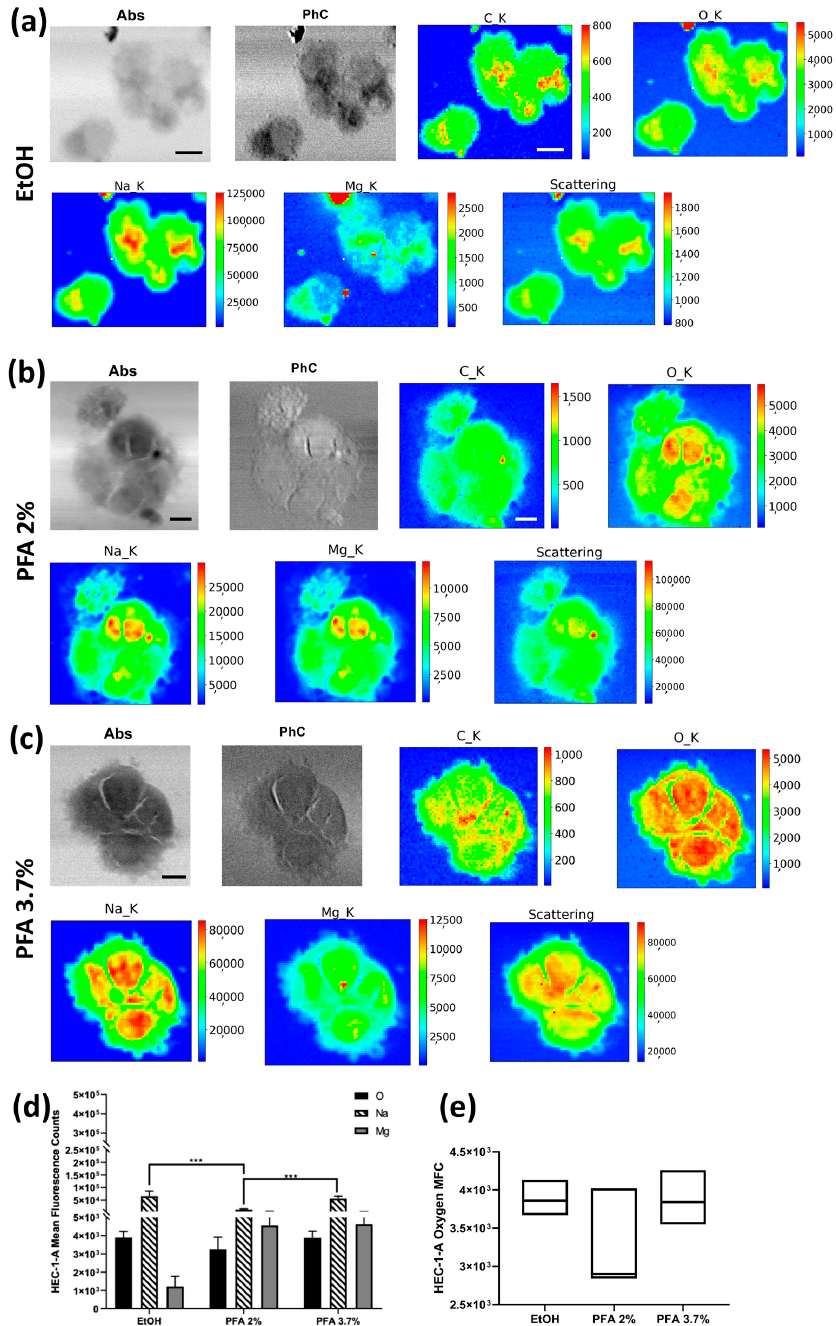
Figure 2. STXM and XRF analysis of the HEC-1-A cell line. Absorption (Abs) and differential phase contrast (PhC) images, alongside with O, Na, Mg, and Scattering maps of HEC-1A endometrial cells fixed with three different methods: ( a ) EtOH 70% (mapped area 60 × 52 µ m 2 ), ( b ) PFA 2% (mapped area 68 × 68 µ m 2 ), and ( c ) PFA 3.7% (mapped area 52 × 52 µ m 2 ). Scale bars are 10 µ m. ( d ) Normalised average XRF counts of O, Na, and Mg in HEC-1-A adenocarcinoma endometrial cells fixed with EtOH 70%, PFA 2%, and 3.7% evaluated on at least 6 cells/fixation method. ( e ) Min-to-max box plot comparing oxygen MFC as obtained by descriptive statistical analysis used to determine the coefficient of variation. A two-way ANOVA with multiple comparisons test was performed to test the statistical difference among the fixation methods. *** p < 0.001. The STXM images (Abs and PhC) and XRF images were acquired at 1500 eV excitation energy with a step size of 200 nm and 800 nm, respectively, and an acquisition time of 10 ms/pixel and 6 s/pixel,